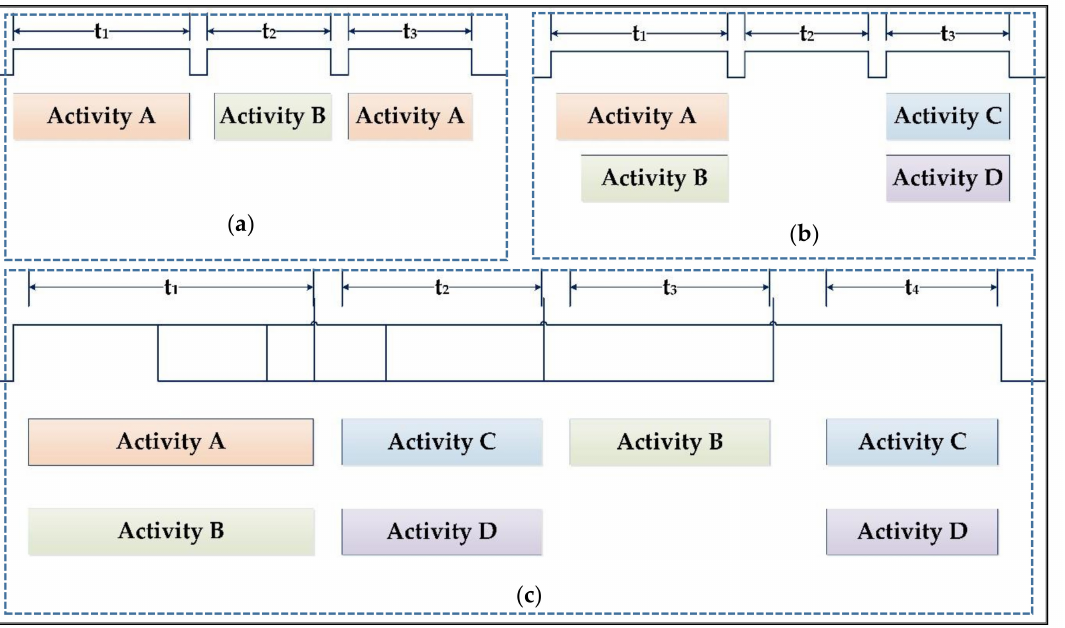
Figure 2. Pictorial view of ( a ) Interleaved Activity occurrence, ( b ) Concurrent Activity occurrence, ( c ) Concurrent and Interleaved